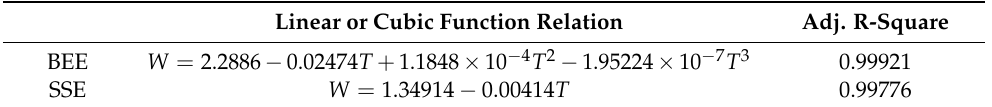
Table 4. Temperature dependence of the PL peak wavelength of the Ag@SiO 2 @CdS/ZnS composite nanoparticle film